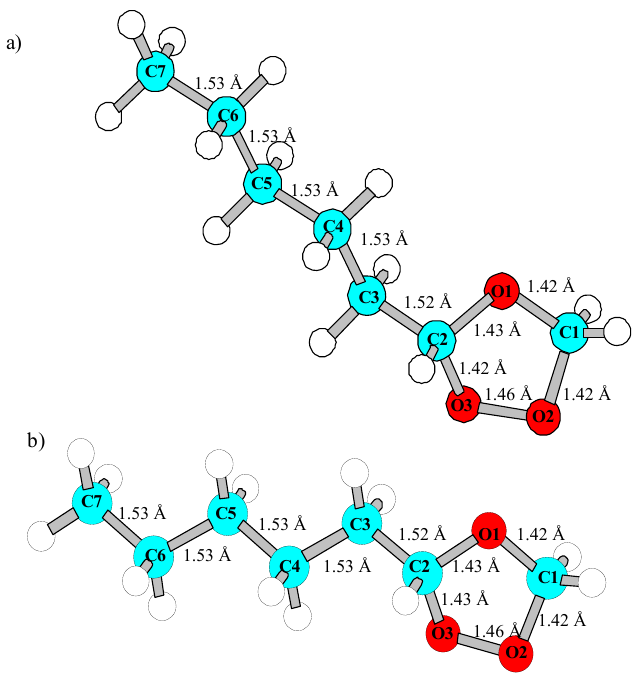
Fig. 6 Theoretically (B3LYP 6-311++G (3df, 3pd)) calculated structure of the most stable 1-heptene SOZ conformers: a) gauche conformer: ∠ O1C2C3C4=-66.3 ◦ ; b) anti conformer: ∠ O1C2C3C4=-177.8 ◦ . The enthalpy difference between them δH = - 0.29